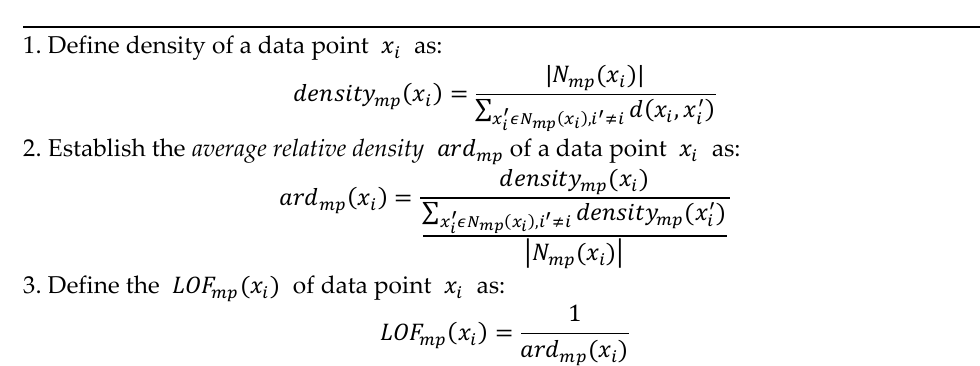
Figure 2. The ROBIN initialization method.